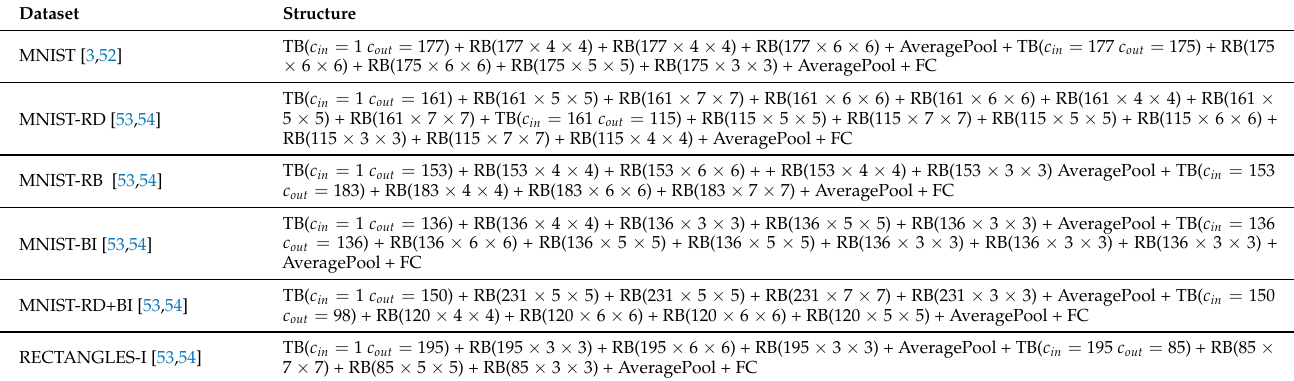
Table 8. The identified best models for all benchmark datasets using resPsoCnn-PB-GB. TB indicates a transitional block which contains a single 1 × 1 convolutional layer and RB indicates a ResNet block which contains two convolutions, as indicated in Figure 3. FC indicates a fully connected layer.